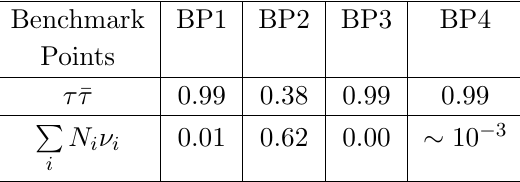
Table 3 . Branching fraction for A for the benchmark points for collider study at the